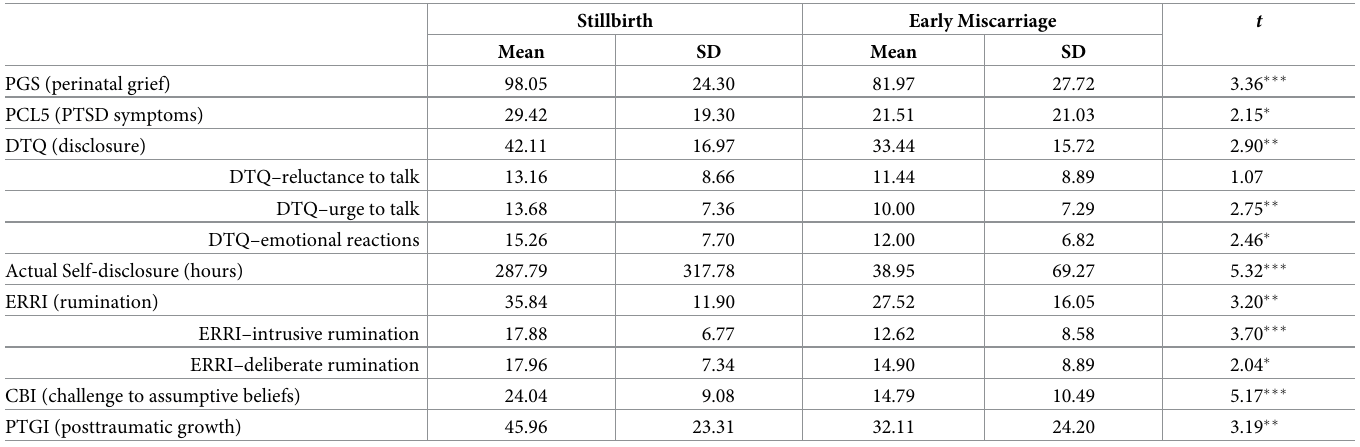
Table 2. Means and standard deviations for questionnaire scores by type of